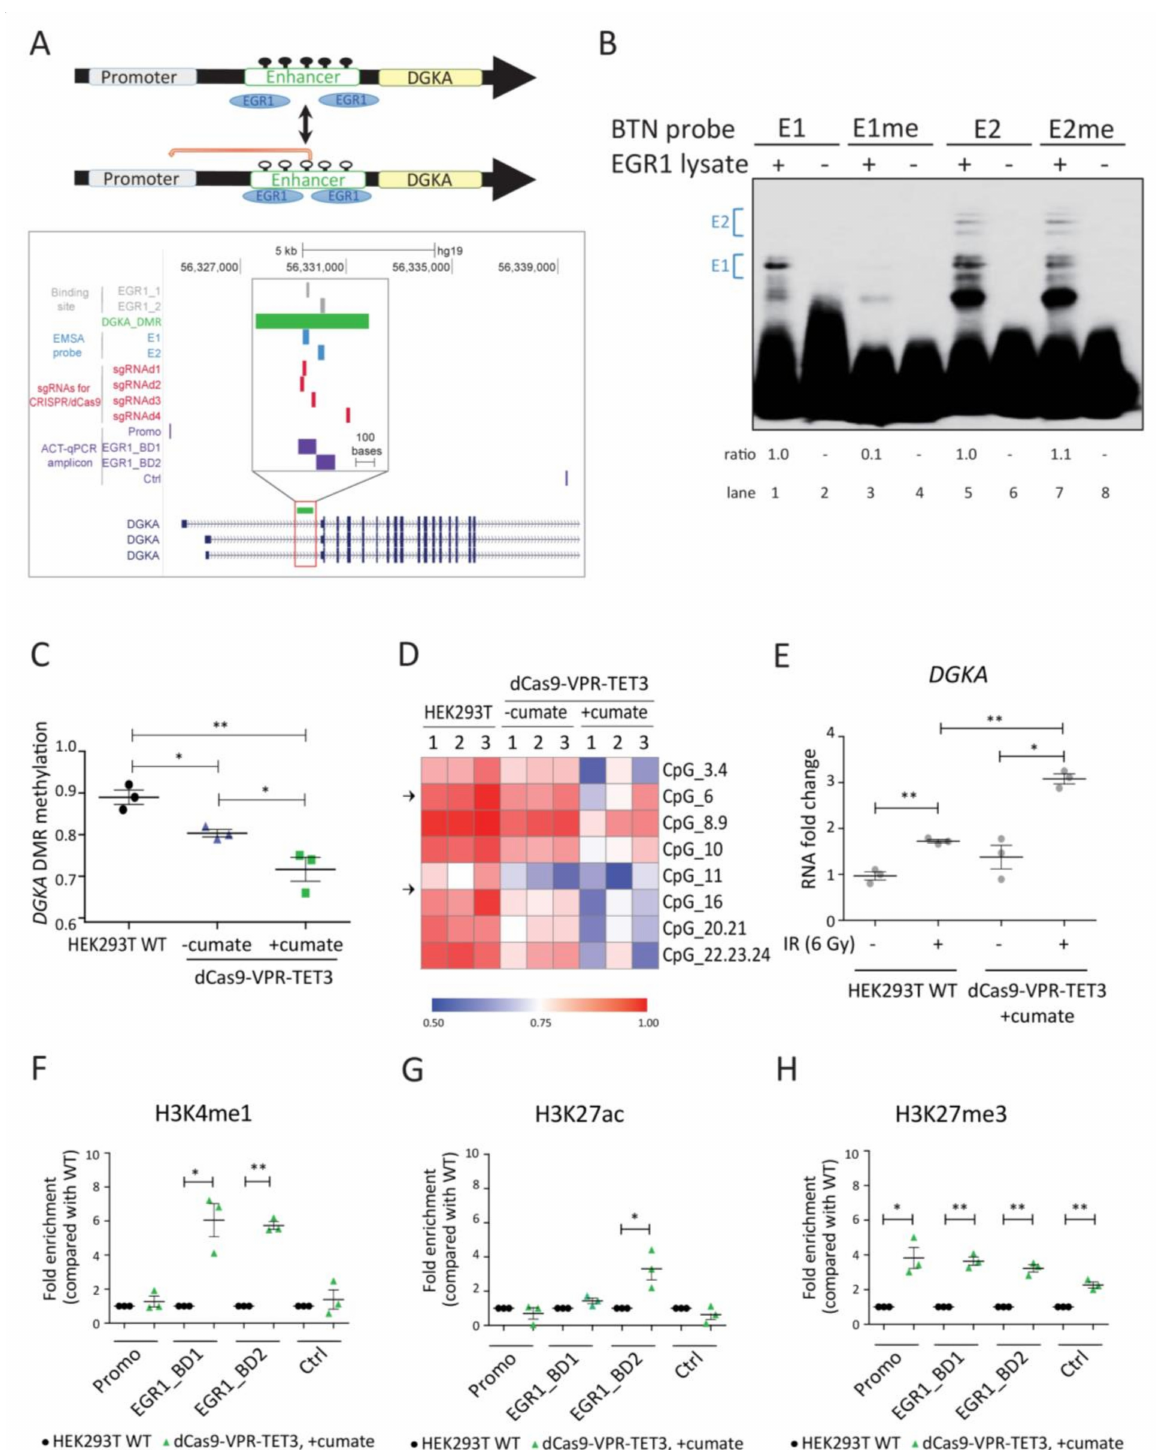
Figure 1. DNA demethylation of the DGKA enhancer region results in increased DGKA expression after irradiation. ( A ) Upper panel: Schematic presentation of the epigenetic regulation at the DGKA locus. Black dots represent methylated CpG sites and white circles unmethylated CpG sites. Lower panel: Map of the interrogated DGKA enhancer region indicating the two EGR1-binding sites (EGR1_1 and EGR1_2, gray), the differentially methylated region (DGKA_DMR) and the amplicon for the EpiTYPER assay (green), regions for EMSA probes (E1 and E2, blue), four sgRNA-targeting sites for CRISPR/dCas9-VPR-TET3 gene editing (red), and amplicons for antibody-guided chromatin tagmentation